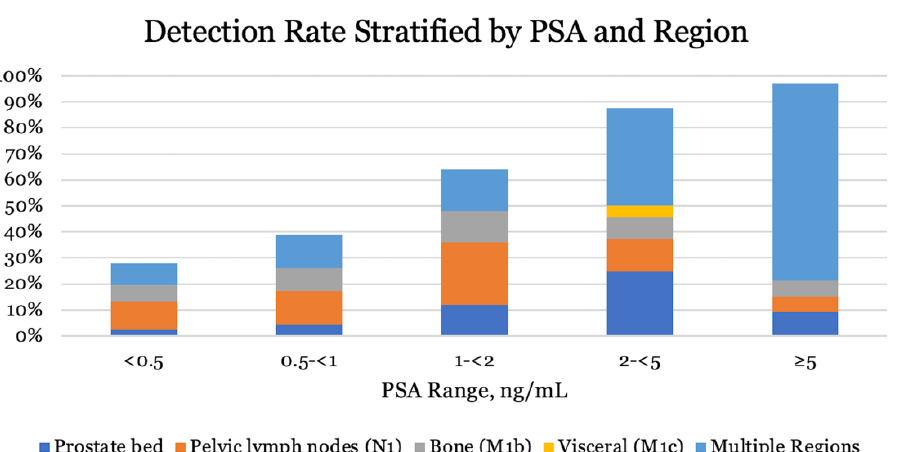
Figure 2. Proportion of patients with 68 Ga-PSMA PET/CT positive findings, stratified by PSA and region in all patients ( n = 189).